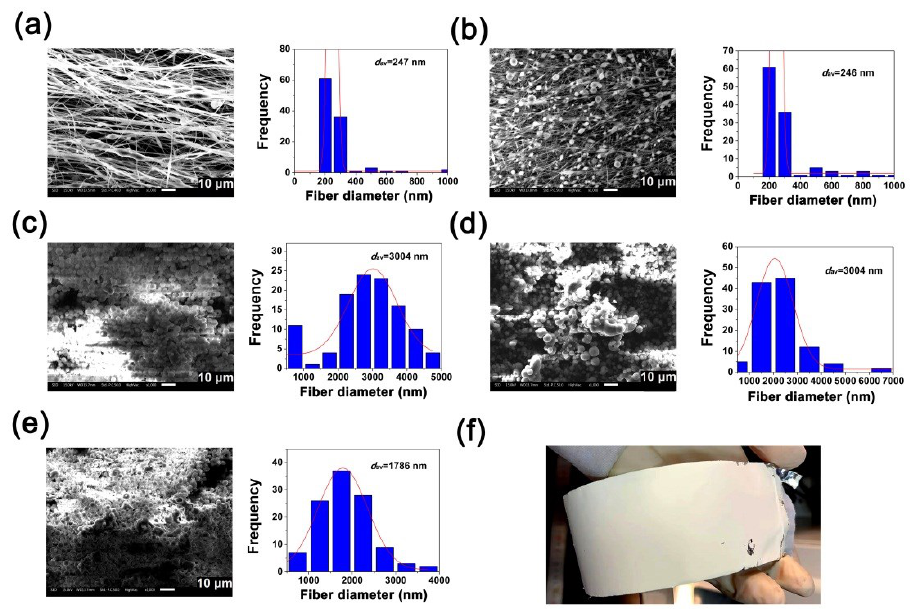
Figure 6. Microscopic ( a – e ) and macroscopic ( f ) morphologies of PI NFMs together with the average diameters of the fibers. ( a – e ) SEM images of SPI-2, SPI-3, SPI-4, and SPI-5 membranes, respectively; ( f ) Appearance of SPI-4 NFM.